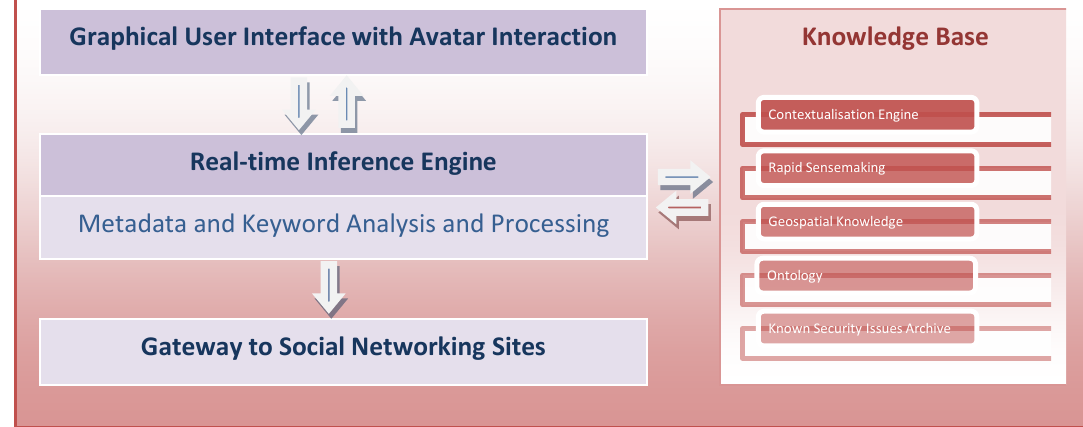
Figure 2. SNeSSI